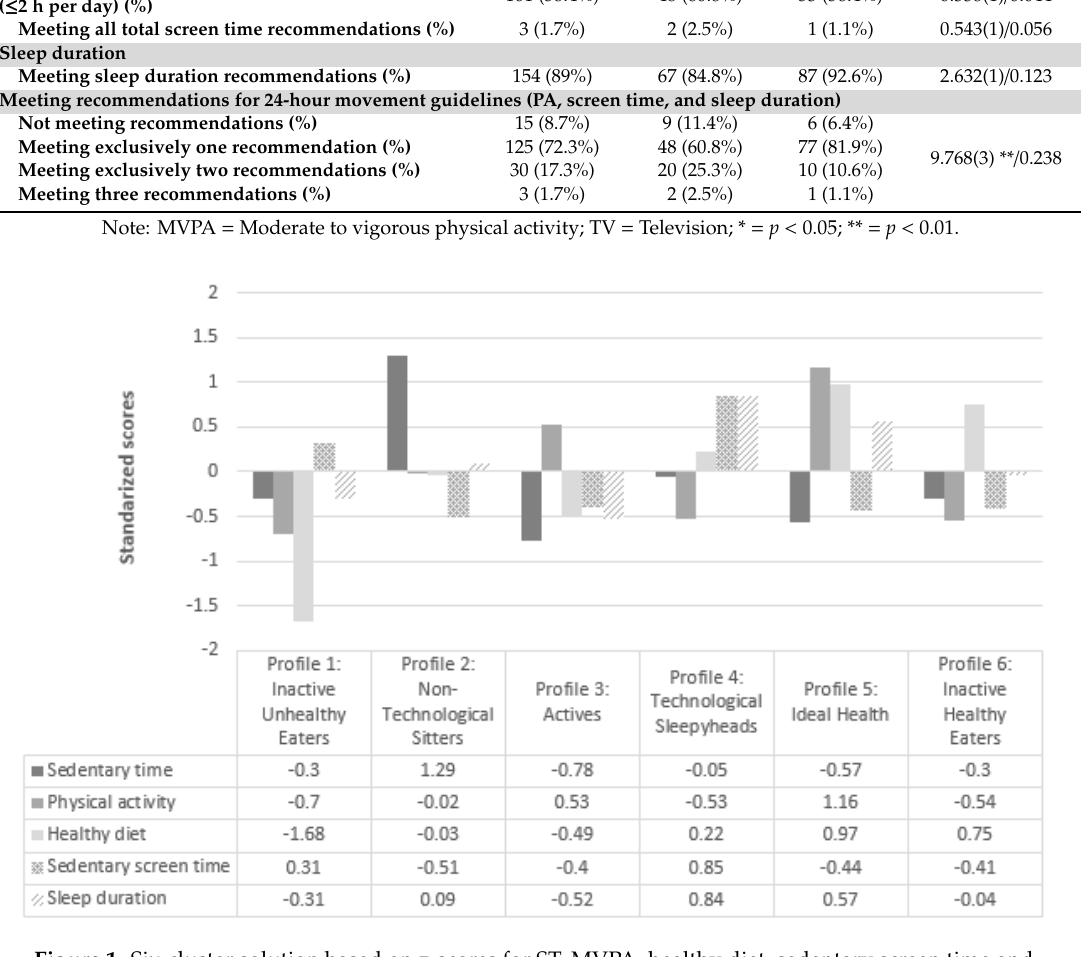
Table 2. Compliance with MVPA, screen time, and sleep duration recommendations and combinations of these recommendations by sex.